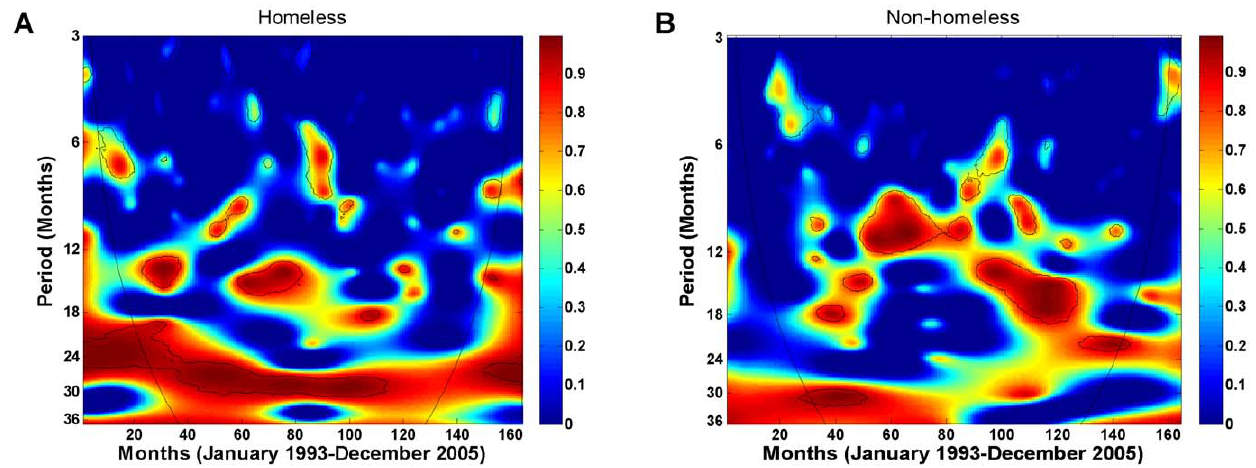
Figure 6. Robustness of coherence and synchrony between the TB cases and their HIV + /PPD 2 contacts, January 1993–December 2005. Wavelet coherence analysis was performed, where each PPD 2 contact with missing HIV status was randomly assigned a status (HIV + or HIV 2 ). The experiment was repeated 500 times and the average coherence was recorded. Each time series was log-transformed and standardized before wavelet analysis was performed. (A) Homeless: the two time series manifest high coherence at the same 27–31 months periodic band, as in Figure 4B, with the lag time of 5.2 months. (B) Non-homeless: similar to Figure 5, there is no evidence of a significant periodic component in spite of missing HIV data